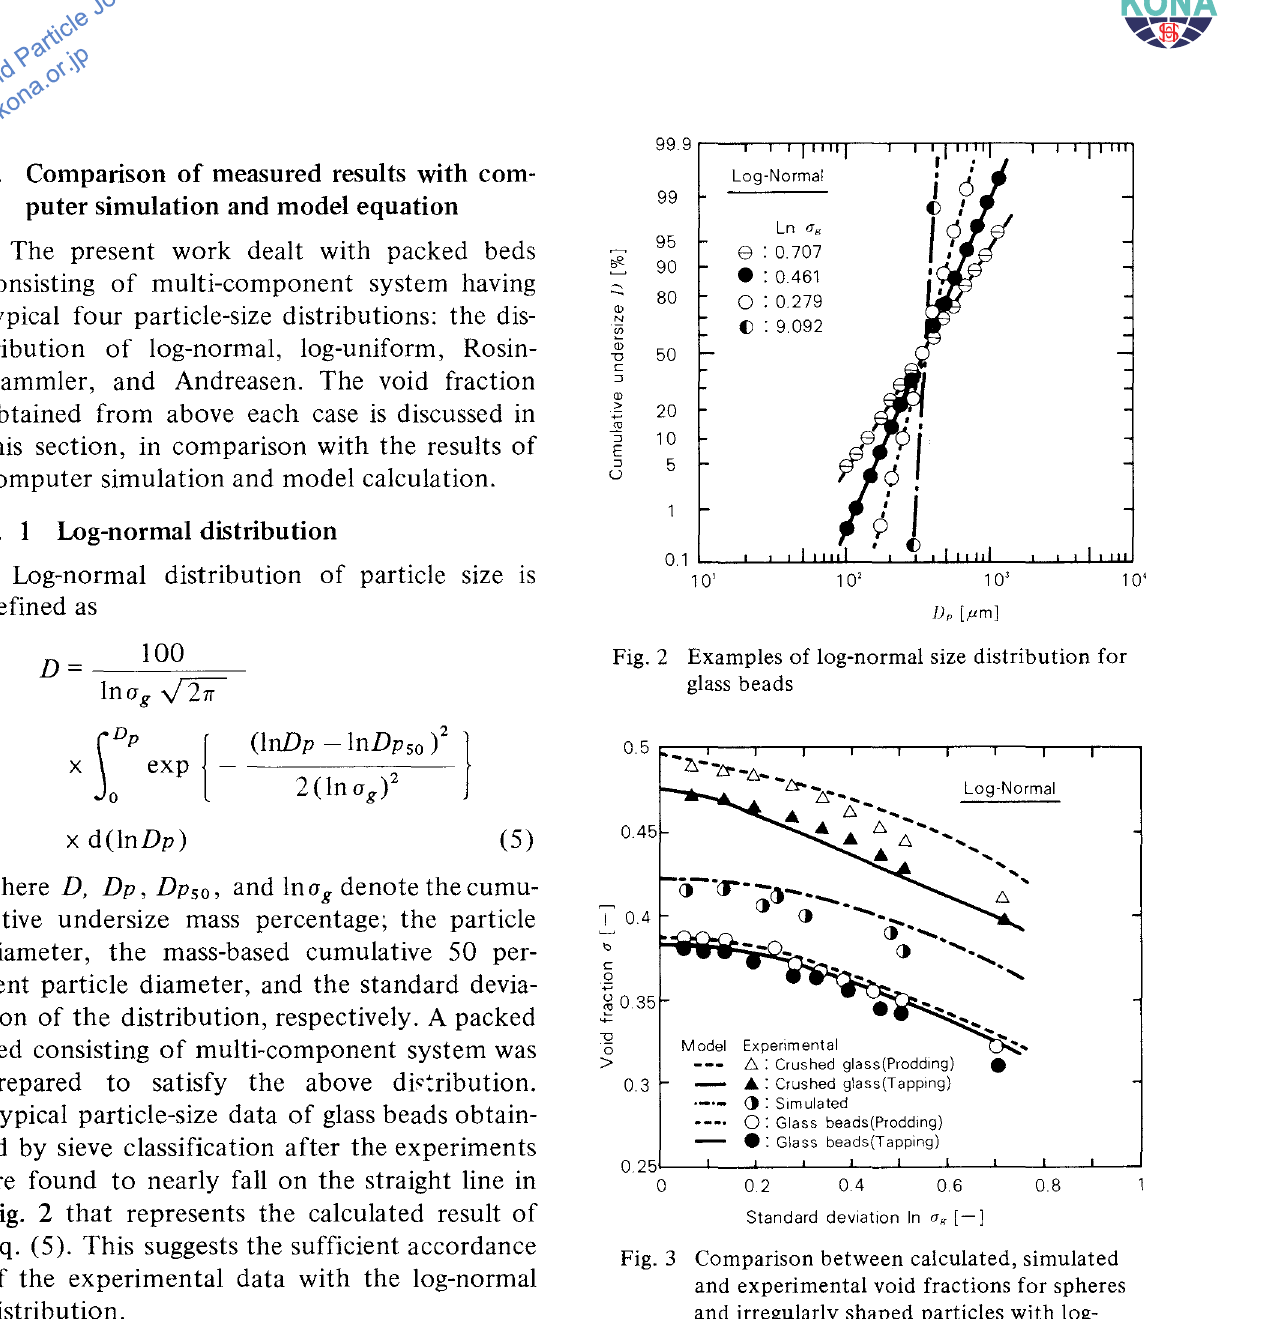
Fig. 3 Comparison between calculated, simulated and experimental void fractions for spheres and irregularly shaped particles with log normal size